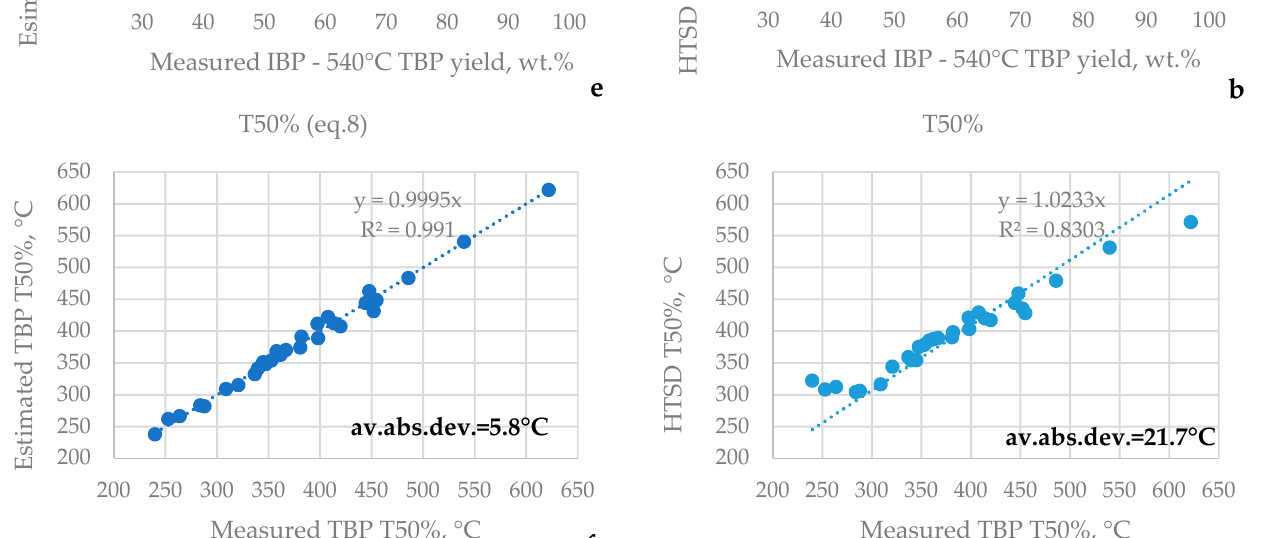
Figure 3. Juxtaposition of the TBP with the HTSD yields of the IBP—360 °C ( a ), IBP—540 °C ( b ), and T 50% (TBP versus HTSD) ( c ) fractions; the estimated TBP yields according to Equation (6) ( d ) and Equation (7) ( e ); the estimated TBP T 50% according to Equation (8) ( f ). These data clearly show that the equations developed in this work provided a better match to the TBP data than the HTSD data themselves. Using Equations (3)–(8) and em- ploying Riazi’s distribution model (Equation (2)), a full TBP curve could be established, with the distillation data of the studied crude oils are presented in Table S6. The studied crude oils enabled the satisfactory prediction of TBP data from HTSD and specific gravity data (deviation in predicted yields of lower than 1.4 wt.%, as required by ASTM D 2892 [11]), except for two crude oils: Oryx (deviation = 3.5 wt.%) and South Green Canyon (de- viation = 3.0 wt.%), whose simulated and actual TBP data are shown in Figure 5. The rea- son for the bigger deviations in TBP yield predictions for these crude oils lies in the poor forecast of the IBP—360 °C fraction yield that resulted in the inadequate prognosis of the lighter part of TBP curve. This is understandable for HTSD, which underpredicts the lighter ends of TBP because of the co-elution of C 4 –C 8 crude oil hydrocarbons with the CS 2 solvent, as stated in the ASTM D 7169 standard [50]. Although the employment of Equa- tions (3)–(8) and Riazi’s distribution model (Equation (2)) enabled the satisfactory predic- tion of TBP data from HTSD and specific gravity data for some crude oils, the deviations in predictions of the lighter part of the TBP curve were larger than the reproducibility of the ASTM D 2892 method. Thus, as reported in [51], a combination of ASTM D 7169 and ASTM D 7900 can provide the accurate representation of full TBP curves for crude oils for minutes instead of the three days required to complete ASTM D 2892 and ASTM D 5236 analyses. Moreover, HTSD can more accurately represents the content of hydrocarbon fractions in heavy oils than the ASTM D 5236 and ASTM D 1160 physical distillation meth- ods [13,52–54].